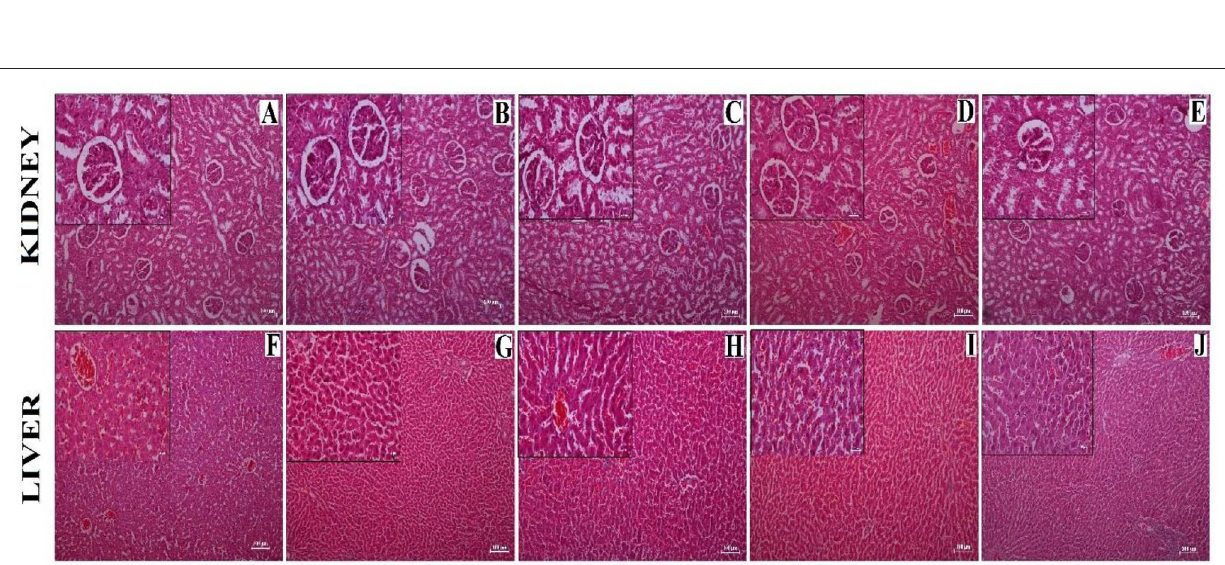
FIGURE 7 | Histological sections showing kidney (A–E) and liver (F–J) obtained from different experimental groups. (A,F) = Normal diet control (ND) group, (B,G) = HCD1 group, (C,H) = HCD2 group, (D,I) = HCD3 group, and (E,J) = Hypercholesterolemic diet control (HCD) group. The main images represent sections observed under 10X magnification; the inset represents 40X magnified images. Scale bars of 100 and 25 µ m are allotted for 10X and 40X magnifications,